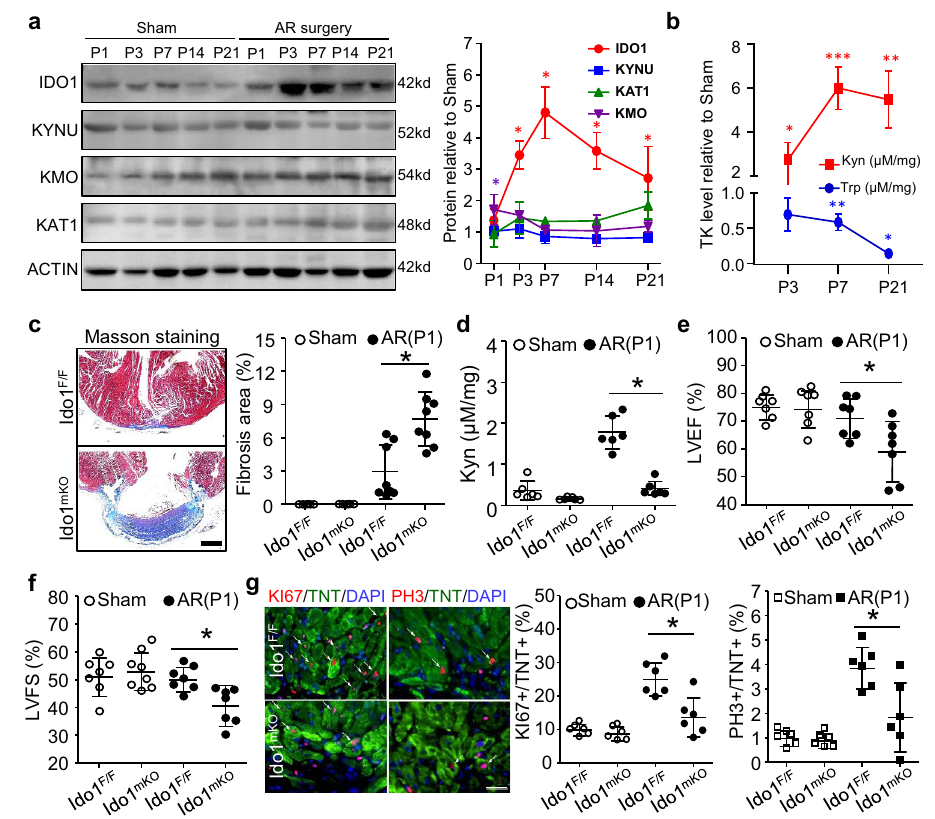
Fig. 1 | IDO1-derived Kyn promotes neonatal heart regeneration. a , b Postnatal 1 day (P1) wild-type mice underwent heart apical resection (AR) or Sham surgery. TheregeneratingheartswerecollectedatP3,P7,P14,andP21. a Westernblotassay andquanti fi cationshowingtheexpressionpro fi lesof tryptophan-kynurenine(Trp- Kyn, TK) metabolic mediators during heart regeneration ( n =6/stage). b Kyn and Trp levels measured by HPLC. * P <0.05 vs. the Sham group at the indicated times ( n =6/stage). c – f Ido1 F/F ( Ido1 Flox/Flox ) and Ido1 mKO ( Tnt Cre ; Ido1 Flox/Flox ) mice underwent ARor ShamsurgeryatP1 and heart wascollected atP21for HPLC, Massonstaining and echocardiography assay. c Representative images and quantitation of fi brosis